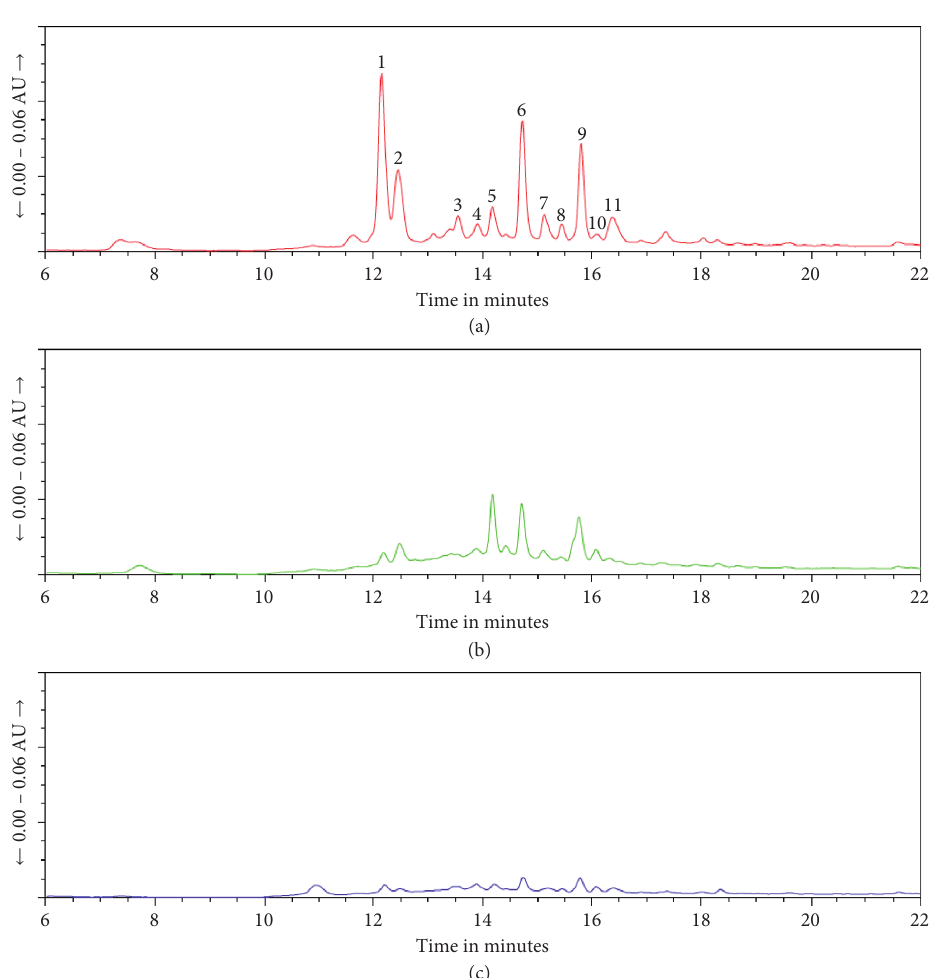
Figure 3: Changes in HPLC patterns of brown teff phenolic compounds (soluble fraction) due to mushroom mycelium-mediated solid-state fermentation. (a) Matched control (unfermented); (b) G . lucidum (KACC 42231); (c) P . ostreatus (KACC